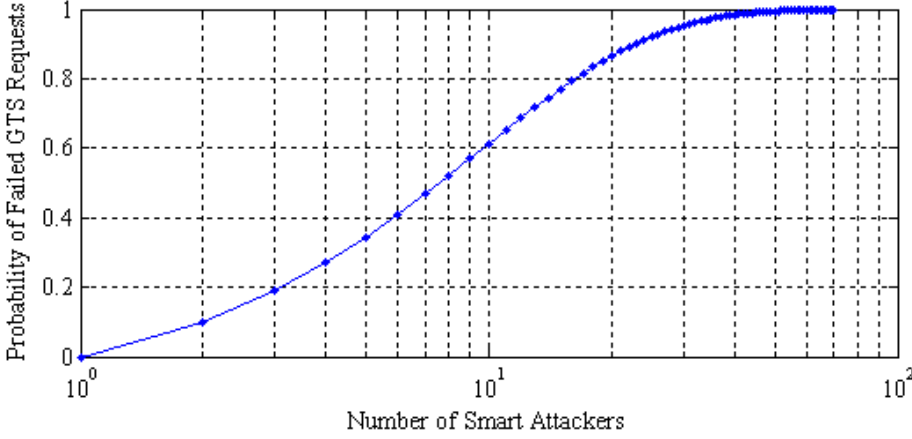
Figure 5. Probability of failed GTS